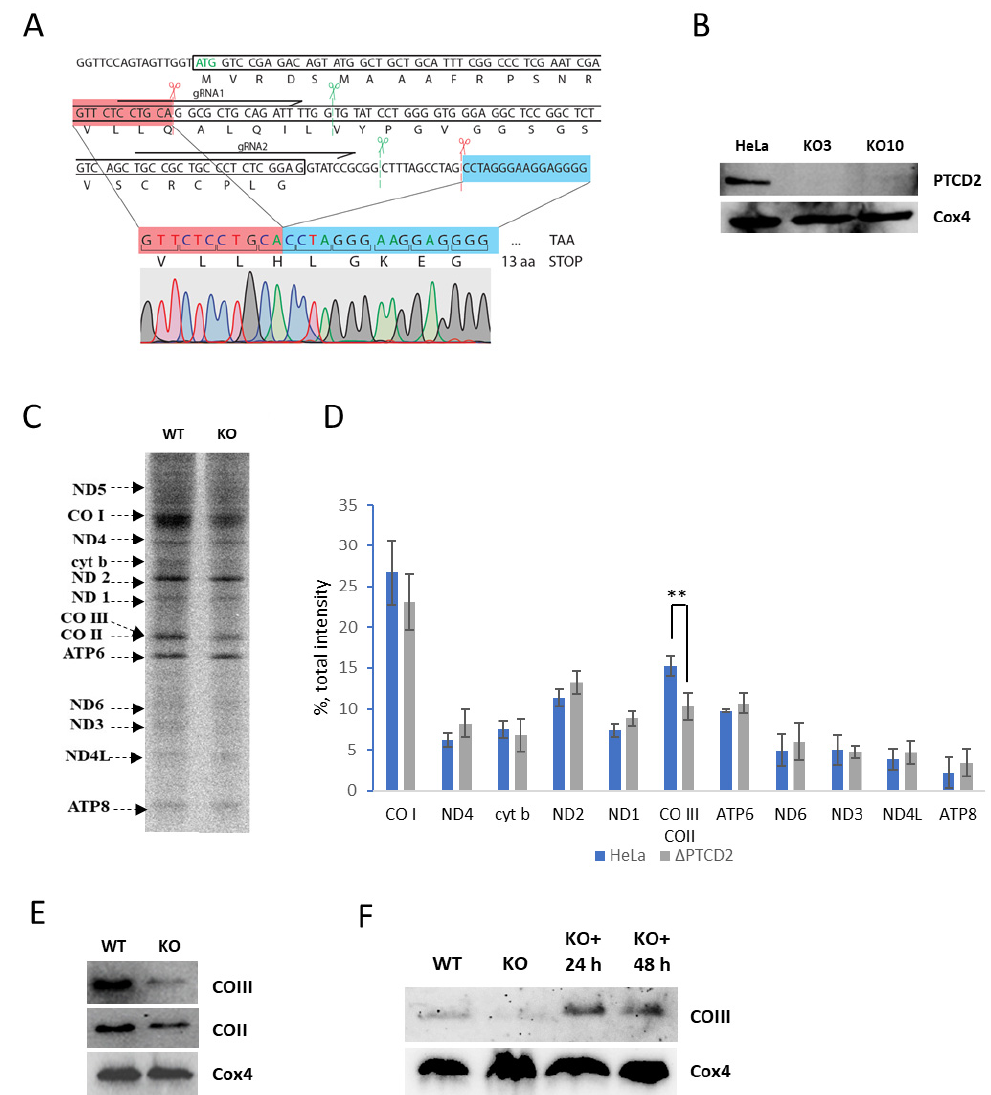
Figure 1. Functional deletion of PTCD2 gene affects translation and steady-state level of COIII protein in human mitochondria. ( A ) PTCD2 gene disruption with CRISPR/Cas9 technology. The sequence of exon 1 is shown in a black box. Start codon is green. SgRNA sequences are shown as black horizontal arrows indicating the direction from 5 ′ to 3 ′ . Green scissors with vertical dashed lines show the intended positions of Cas9 cleavage. Red scissors with vertical dashed lines show the real positions of Cas9 cleavage. The DNA ends joint together after Cas9 cleavage and DNA repair are shown in red and blue boxes, and the region between them was deleted, which is proved by sequencing chromatogram. ( B ) Western blot analysis of wild-type HeLa and PTCD2 knock-out cell lysates with antibodies against PTCD2 and Cox4. ( C ) Mitochondrial translation products of HeLa (WT) and knock-out cells (KO). Cytosolic translation was blocked by cycloheximide and cells were exposed to 35 S-methionine as described in Materials and Methods. Newly synthesized proteins are designated at left, representative radioautograph shown ( n = 4). ( D ) Quantification of mitochondrial translation products in wild-type HeLa and PTCD2 knock-out cells. Mean values ± SD are shown, n = 4, **— p -value < 0.01 by Student’s test. ( E ) Western-blot analyses of HeLa and PTCD2 knock-out cells lysates with antibodies to COIII, COII and Cox4. ( F ) Phenotype restoration. Western blot analyses of HeLa (WT), knock-out (KO), knock-out with insertion of PTCD2 cDNA induced with doxycycline for 24 h (KO+ 24 h), and 48 h cells lysates with antibodies against COIII and